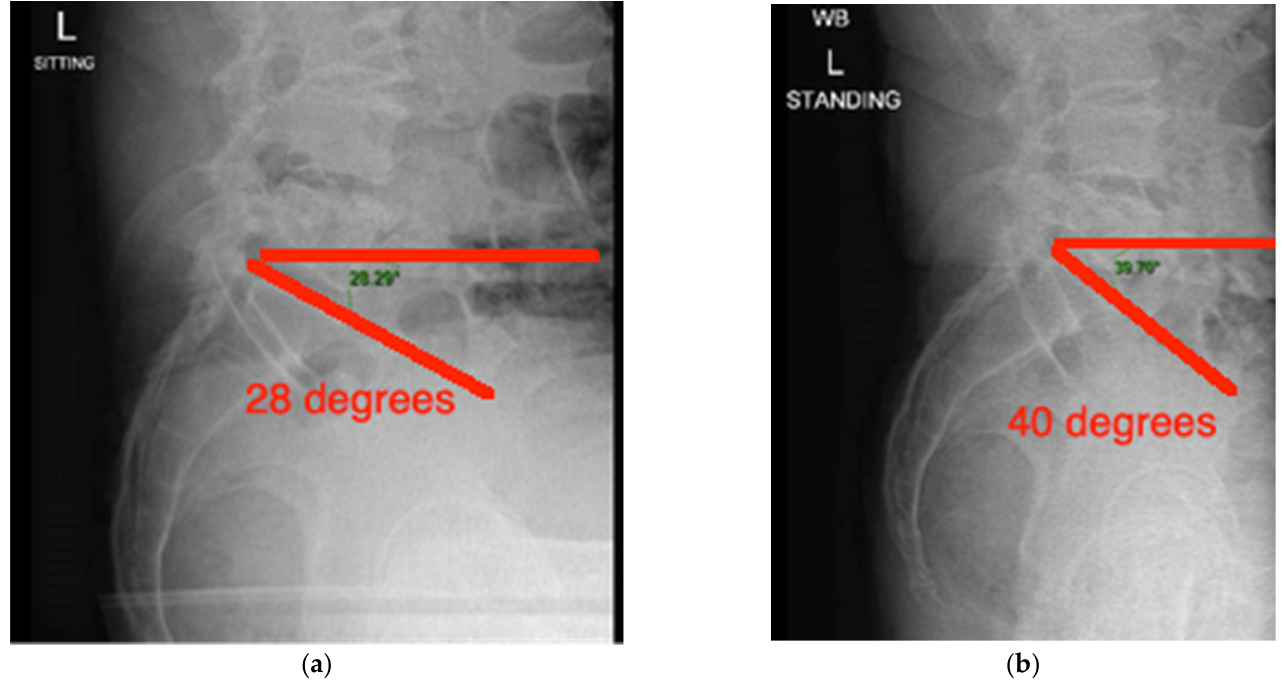
Figure 1. ( a ) Calculation of the sacral slope with sitting X-ray on the left (28 degrees) and ( b ) standing X-ray on the right (40 degrees). This signifies normal change from upright to sitting position as the difference is 12 (between 11 and 29).